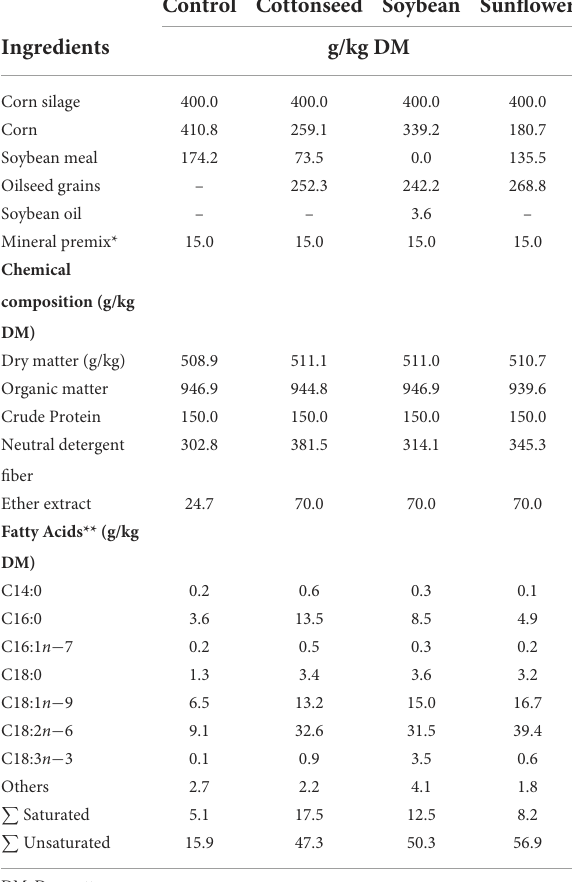
TABLE 1 Ingredients and chemical composition of experimental